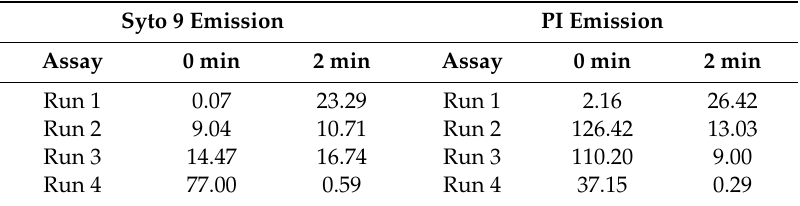
Table 5. The relative values of Syto 9 (green) and PI (red) fluorescence emission during the first 2 min of the four assays of Product